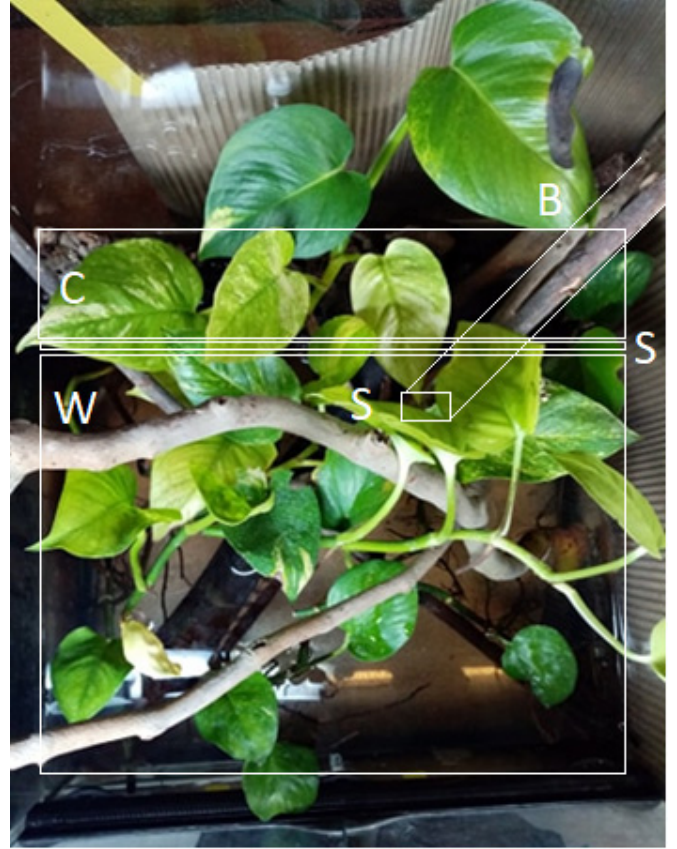
Figure 1. The view from above a typical 45 cm 3 Exo Terra vivarium setup, furnished with appropri- ately sized branches for the animal’s size, including live devil’s ivy ( Epipremnum aureum ), and a cork land area (C) with a water body (W) with a depth to the cork land area. Shorelines (S) were recorded where the water body met the cork land area and submerged branches. The branch resource areas (B) were recorded as any above water branch area. Resource areas for the cork and branches were further divided into bask and non-bask resources. More exposed resources in this study were noted as the branches within and outside of the bask zone, the shoreline, and the water body. The cork within and outside of the bask zones were noted as being less exposed, as they were more sheltered from overlying branches and vegetation. Labelled resource areas in this figure are representative and not to scale. Corrugated cardboard outside each vivarium restricted between-vivaria visibility of lizards occupying neighbouring vivaria.